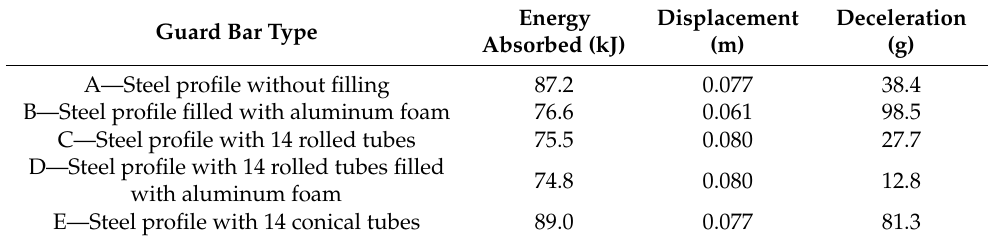
Table 6. Concepts of the RUPD guard bar.